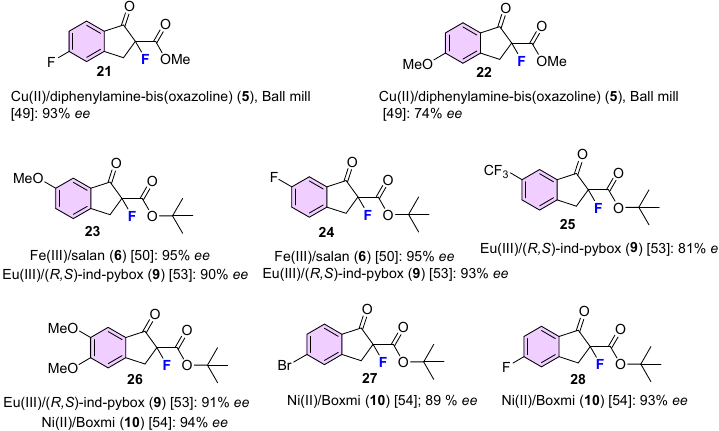
Figure 3. Results for substituted derivatives 21 – 28.